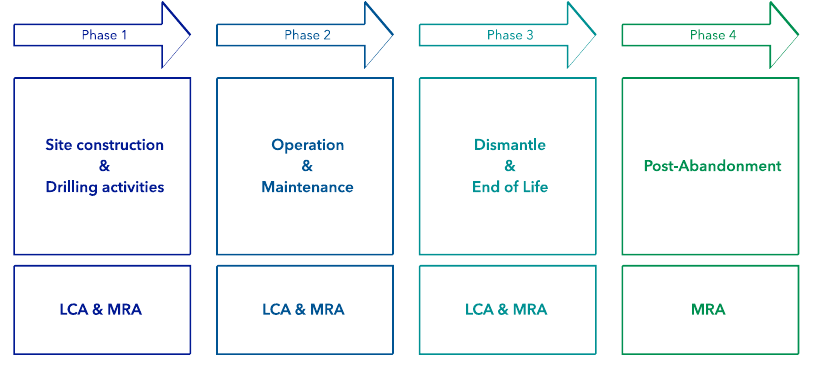
Figure 5. MRA and LCA: Project phases.